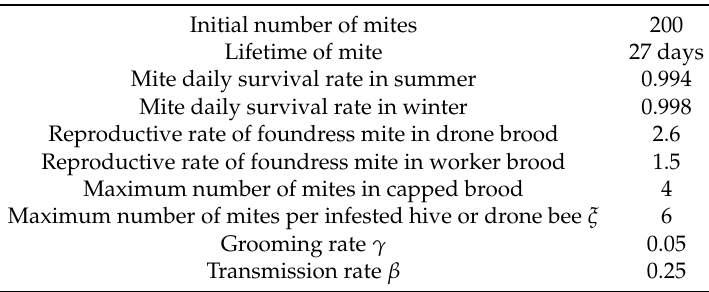
Table 5. Simulation parameters with